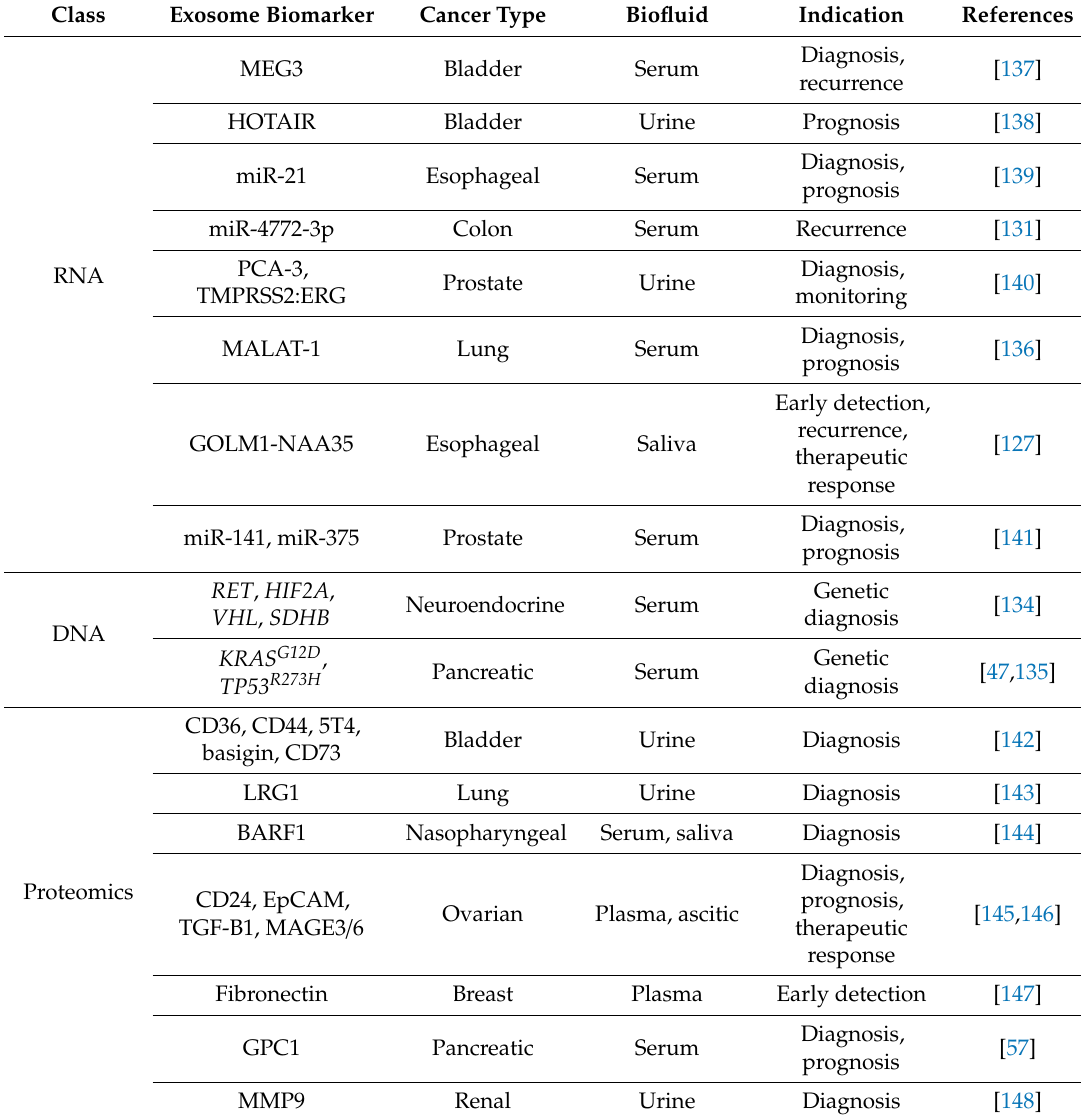
Table 3. Proposed indication of EV signatures from human body fluids in di ff erent cancer